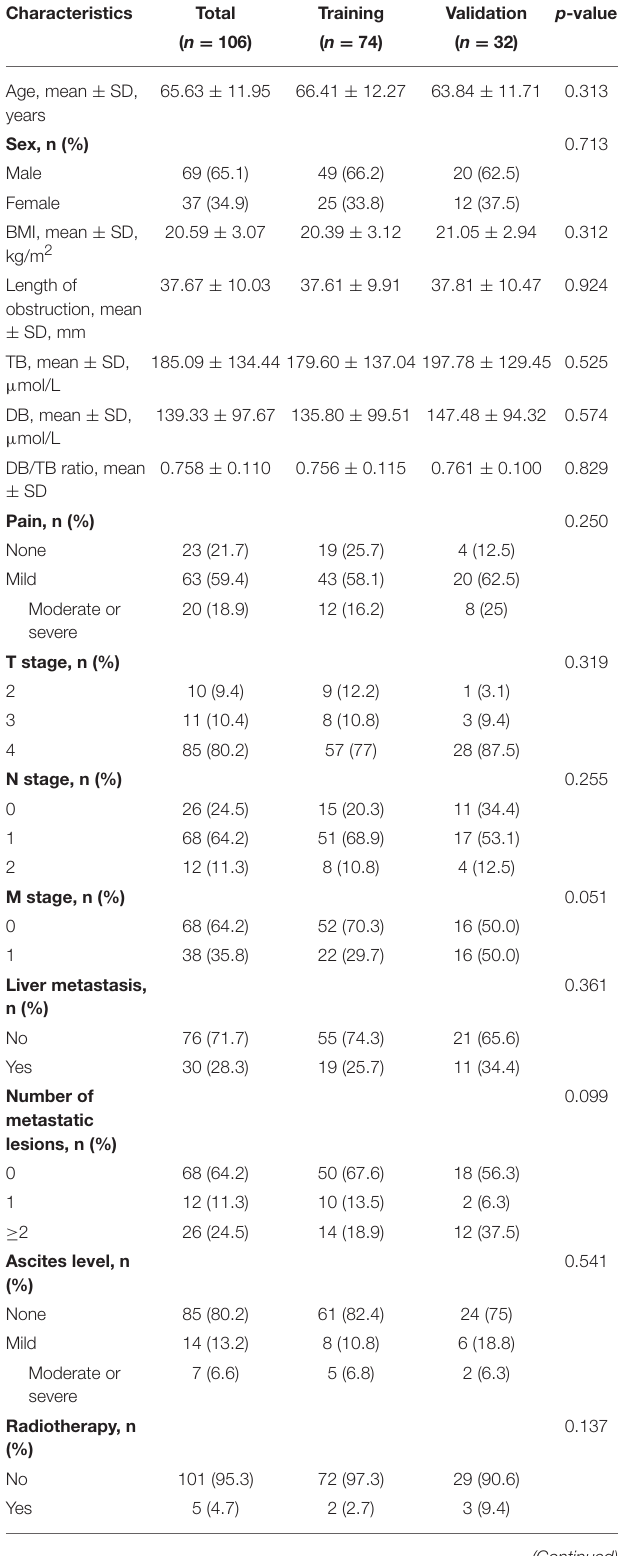
TABLE 1 | Patient characteristics in the training and validation